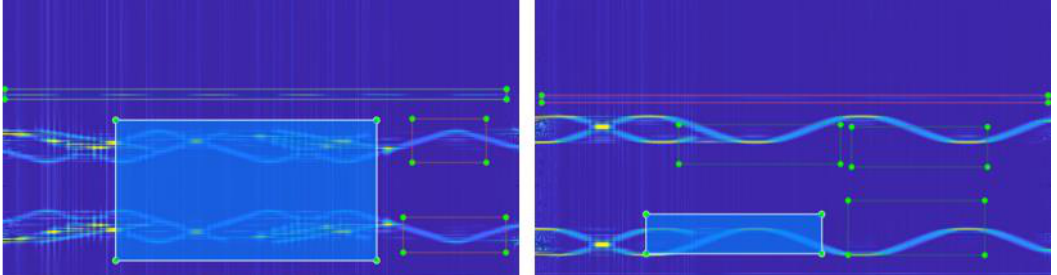
Figure 11. Range of labels in the case of multiple signal overlap.